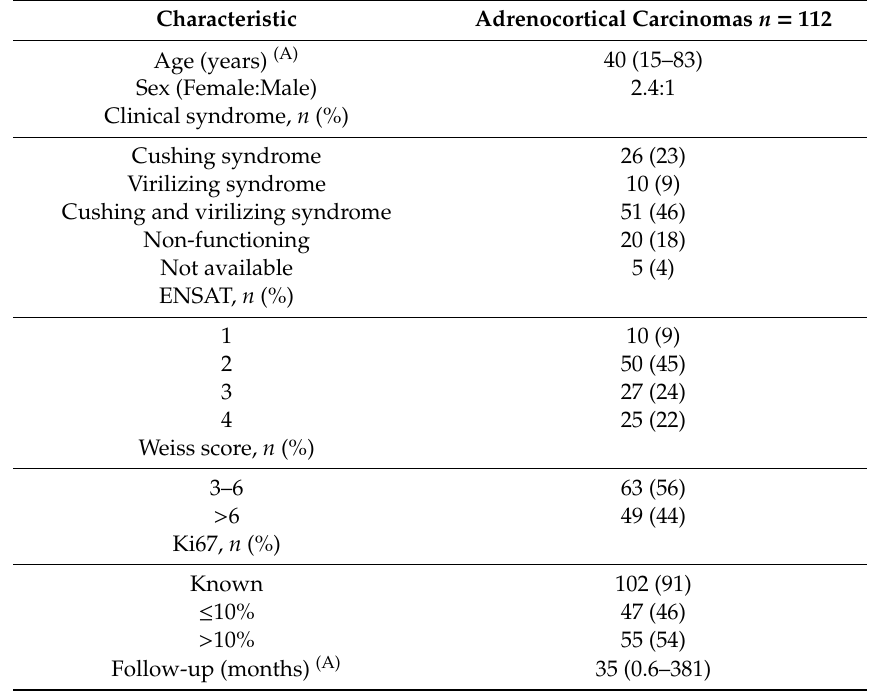
Table 4. Clinical and tumor characteristics of 112 adult patients with ACC included in the